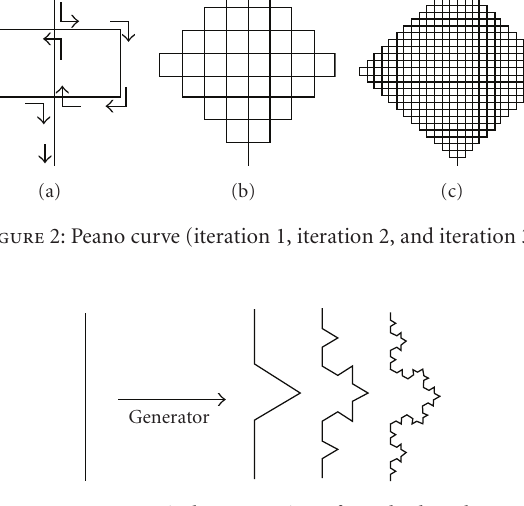
Figure 3: A geometrical construction of standard Koch